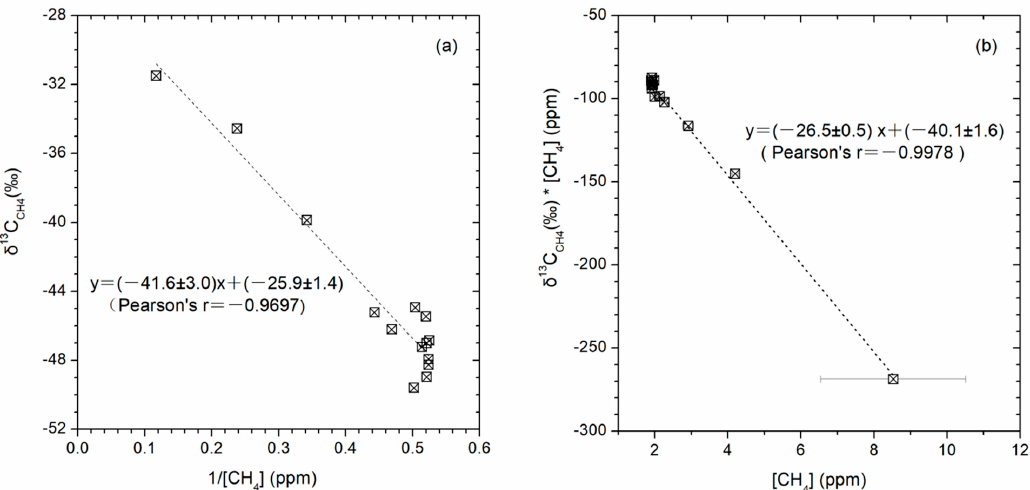
Figure 6. Qualitative assessment of source CH 4 isotopic composition. ( a ) Keeling plot showing the relationship between δ 13 C CH4 and the inverse of CH 4 content with the intercept of the regression as δ s. ( b ) Miller-Tans plot showing the relationship between δ 13 C CH4c * [CH 4 ] content and the slope of the regression as δ s.